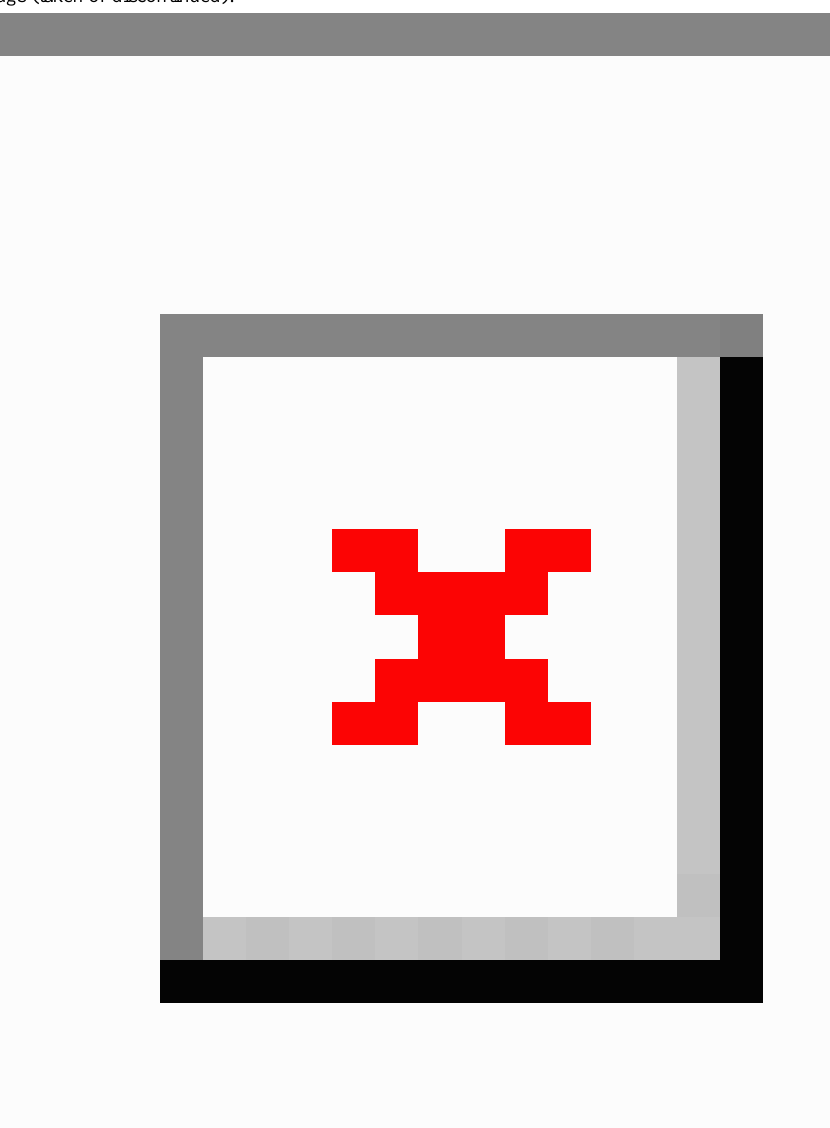
Figure 6. The oncological dashboard via Web browser. The horizontally tiled charts show general data, eg, weight, fever, symptoms, personal observations, and drugs (taken or